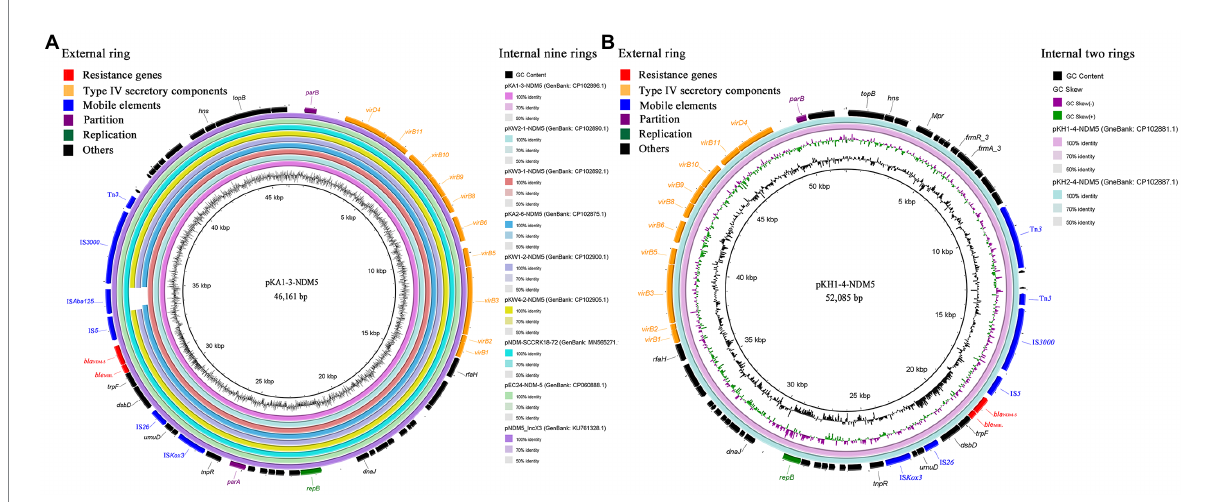
FIGURE 2 The blast and annotation of bla NDM-5 -carrying IncX3 plasmid genomes (constructed by BRIG). Genes are color-coded depending on functional annotations. (A) The nine internal rings represent different bla NDM-5 -carrying IncX3 plasmids from this study and GenBank database. The external ring represents the annotation of plasmid pKA1-3-NDM5. (B) The two internal rings represent plasmid pKH1-4-NDM5 and pKH2-4-NDM5. The external ring represents the annotation of plasmid